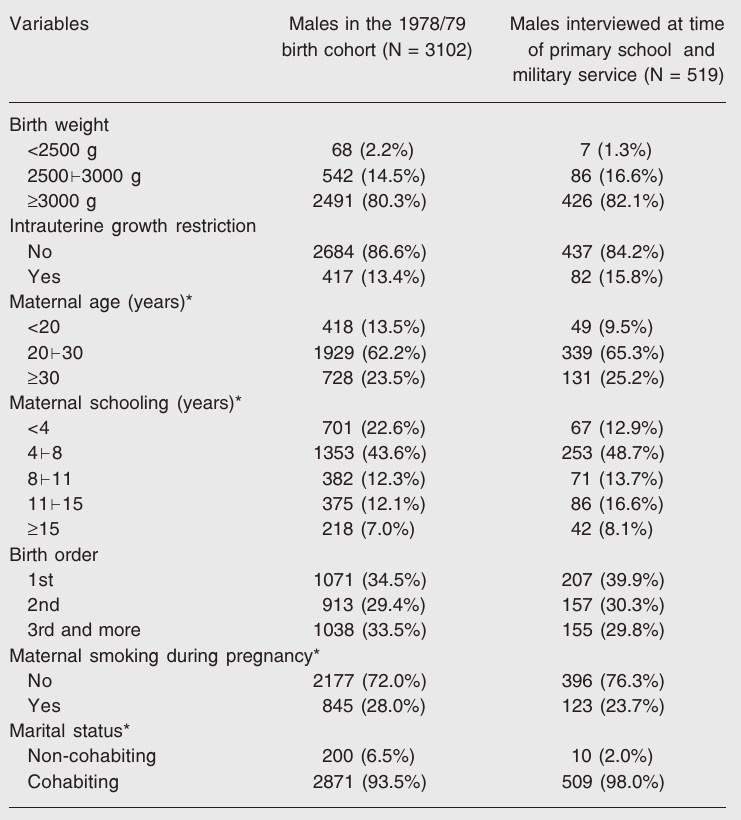
Table 2. Comparison of some baseline characteristics of males from the entire 1978/ 79 Ribeirão Preto birth cohort and those interviewed at primary school age (8-11 years old) and at the time of military service (18 years old).